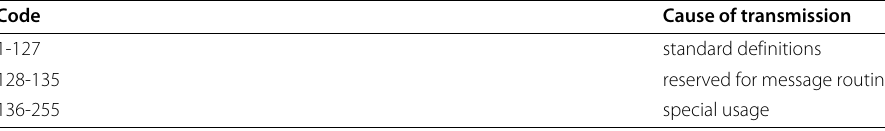
Table 1 Mapping of Transmission causes to field